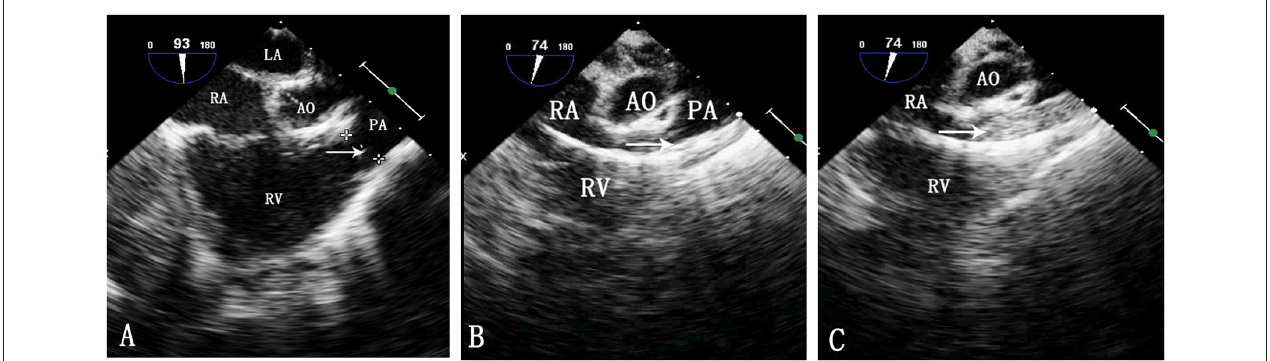
FIGURE 1 | TEE image during pulmonary balloon valvuloplasty. LA, left atrium; RA, right atrium; Ao, aorta; RV, right ventricle; PA, pulmonary artery. (A) Measurement of the pulmonary valve annulus by TEE. The arrow shows the pulmonary valve annulus. (B) Passing of the catheter through the pulmonary artery. The arrow indicates the catheter. (C) Inflation of the balloon. The arrow indicates the balloon.